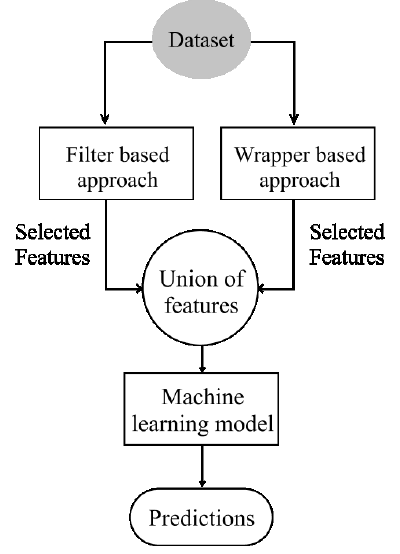
Fig. 2. Generalised Working of Proposed Method